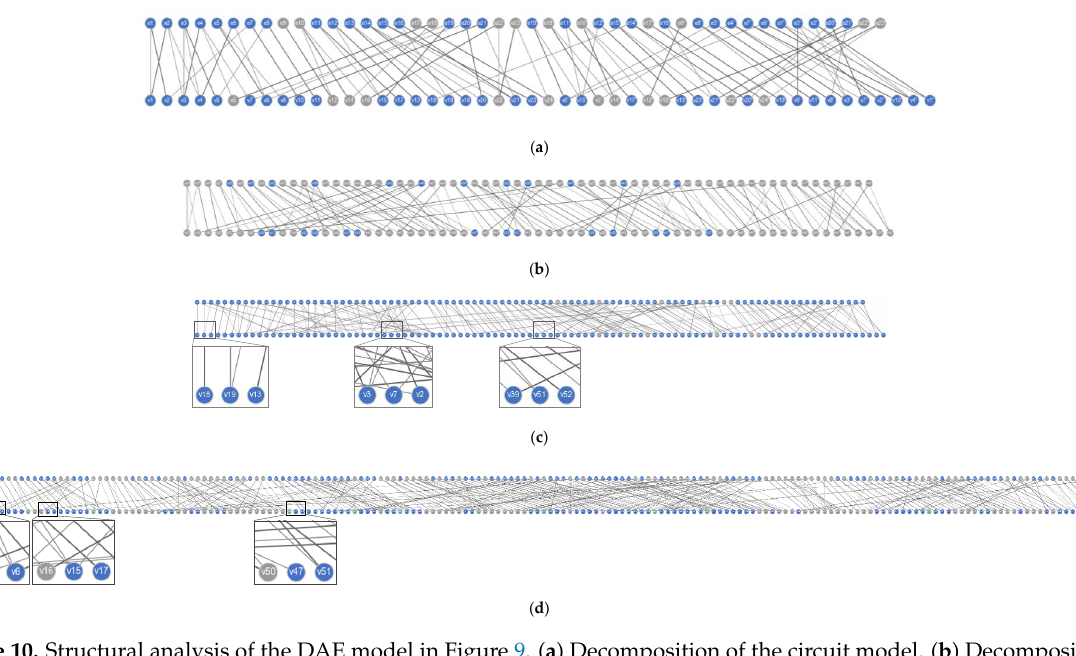
Figure 10. Structural analysis of the DAE model in Figure 9. ( a ) Decomposition of the circuit model. ( b ) Decomposition of the driver model. ( c ) Structural analysis result of the dummy model. ( d ) Structural analysis result of the flattened